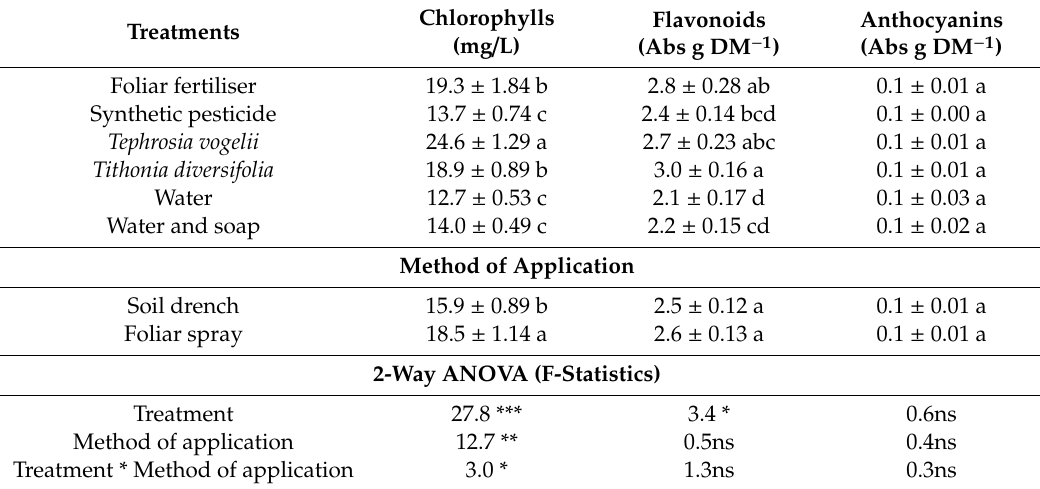
Table 2. E ff ect of treatment on the presence of key metabolite groups in common bean.